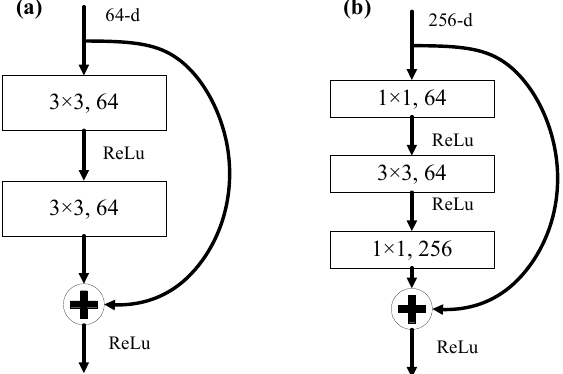
Figure 5. Examples of building block with shortcut connections for the residual network (ResNet). ( a ) Normal block at the C2 stage of the ResNet18 and ResNet34; and ( b ) bottleneck block at the C2 stage of the ResNet50-ResNet1000. ReLu is rectified linear units; 64-d is depth of 64; and 256-d is depth of 256. The figure was redrawn from He, et al. [29].